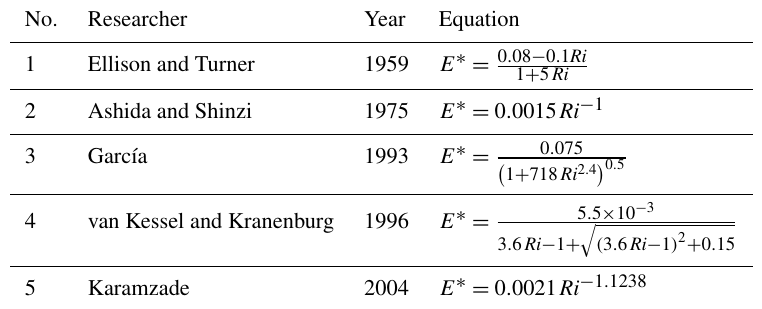
Table 2. Some of the published E ∗ equations based on Ri (Kashefipour et al., 2010). No.